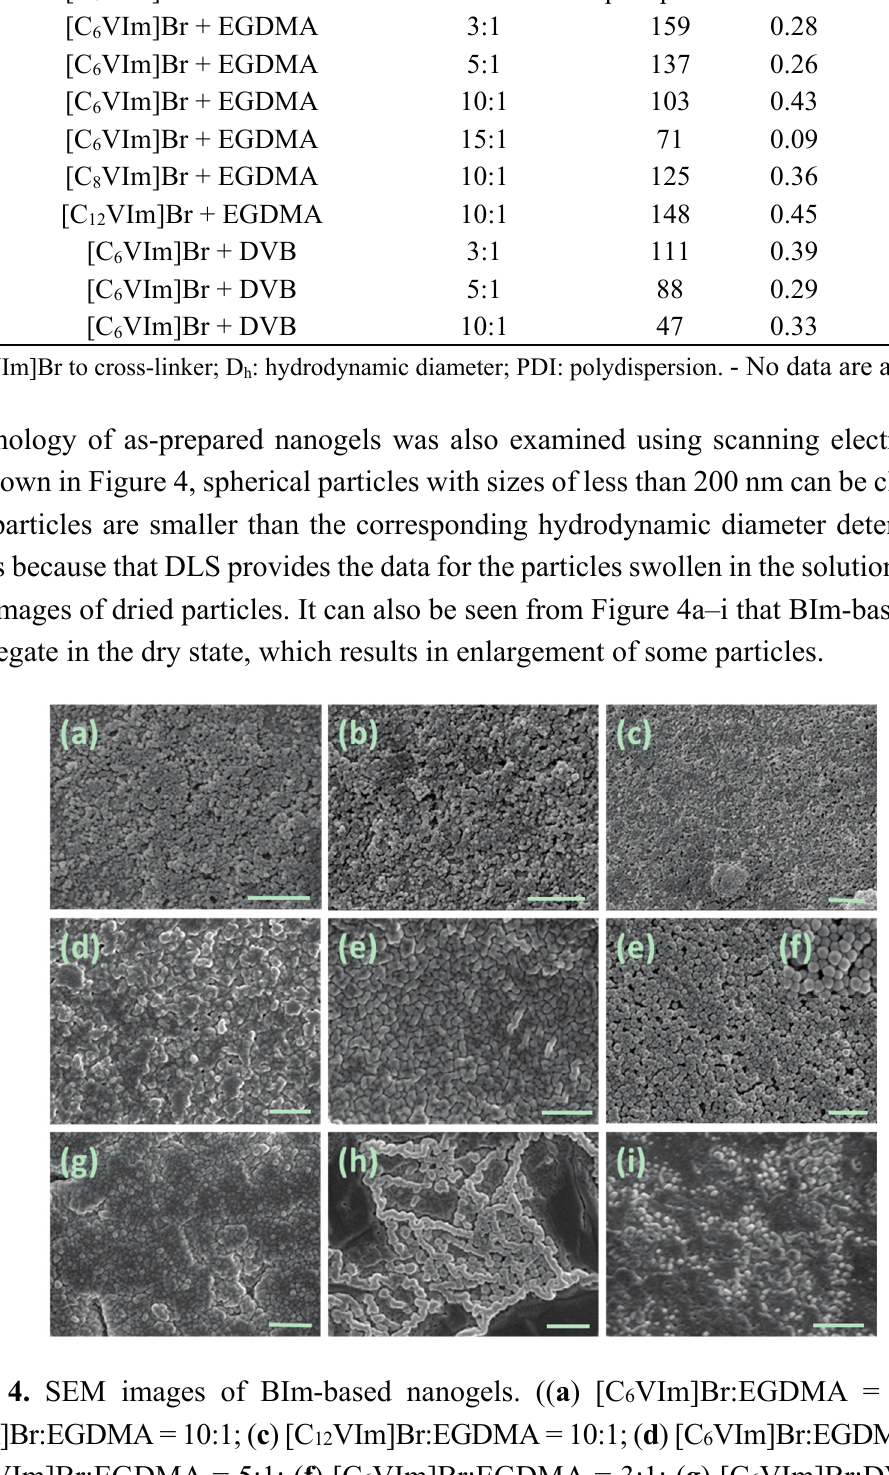
Feed Ratio (Molar Ratio) a